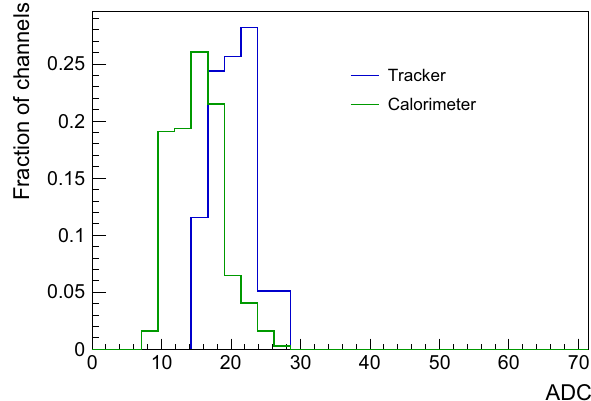
Fig. 12 Noise distribution in the channels of the tracking layers (blue) and the calorimeter layers